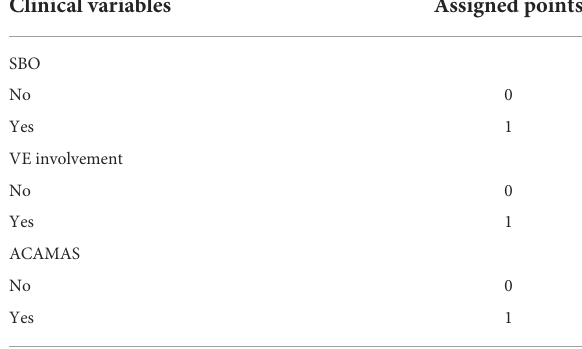
TABLE 2 Characteristics, management, and outcomes of IPR (n = 16).